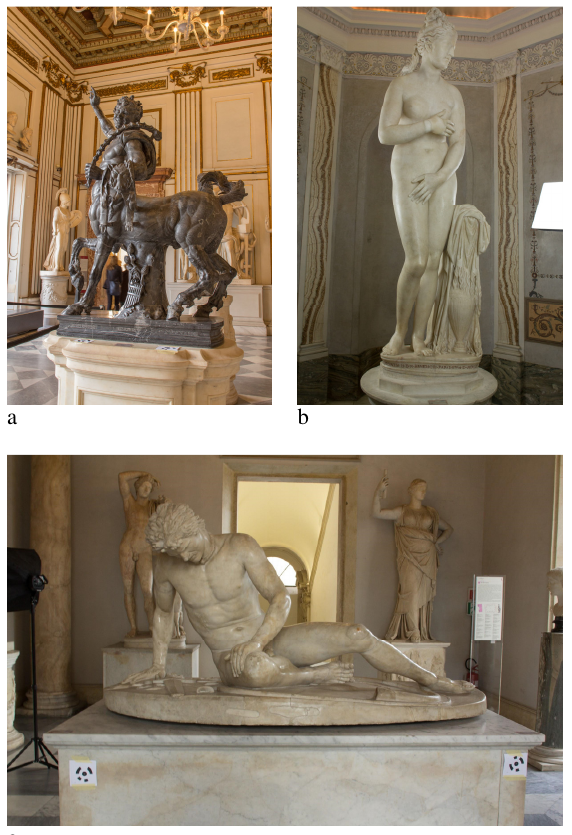
Figure 1. Three examples of statues held in the Capitoline Museums that have been surveyed: (a) the Young Centaur; (b) the Capitoline Venus; (c) the dying